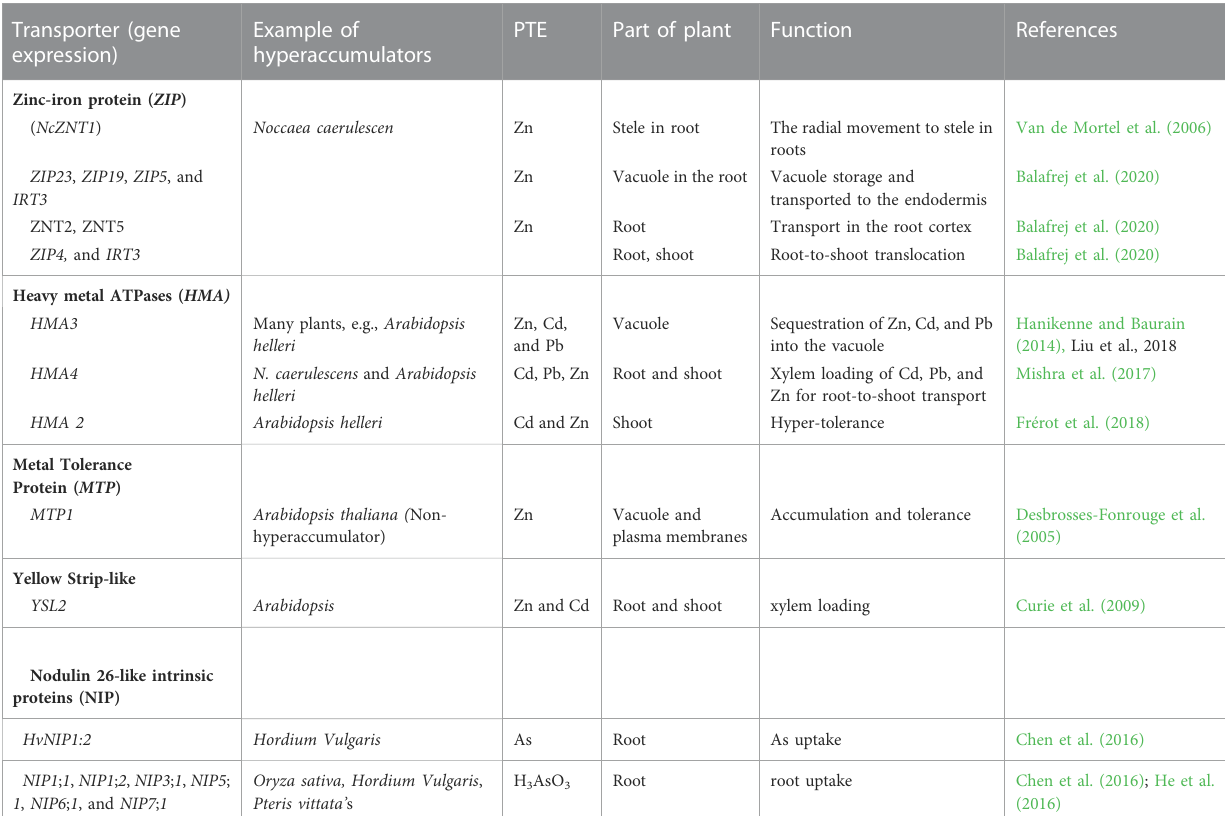
TABLE 2 Examples of types of protein transporter and